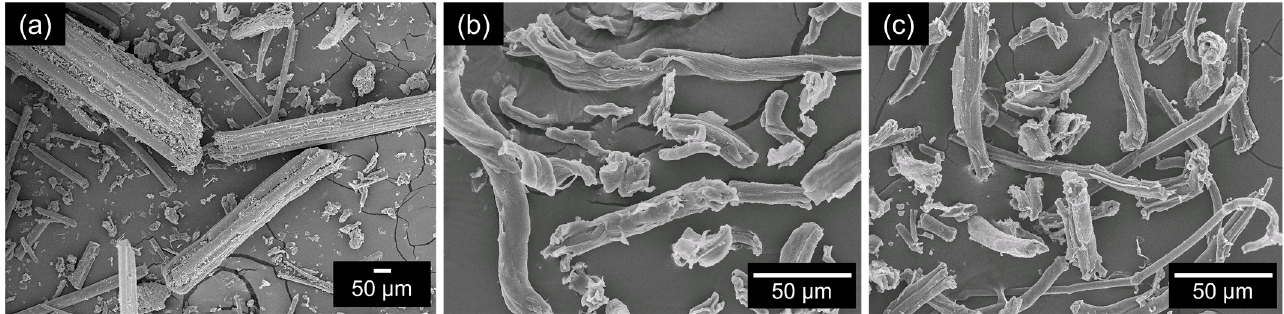
Figure 2. SEM images of ( a ) crude bamboo fi ber at 100×, ( b ) pulp at 500×, and ( c ) cellulose at